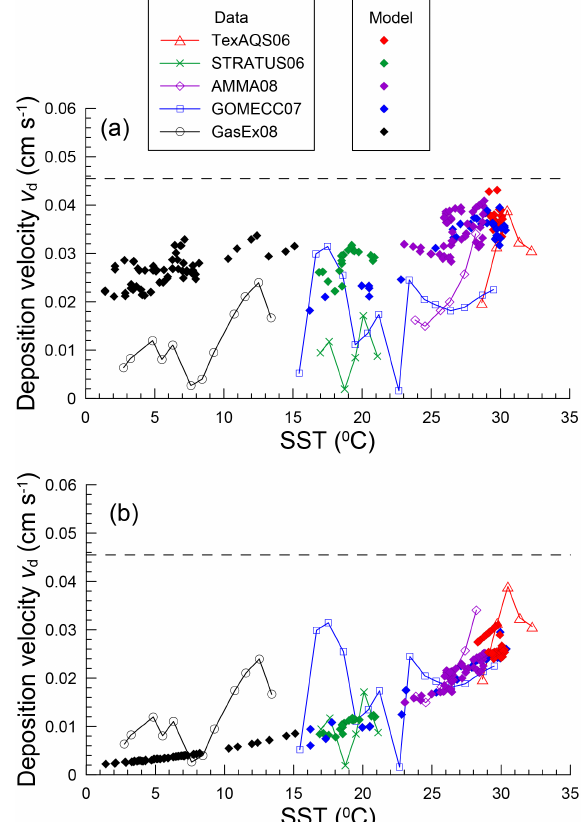
Figure 2. Ozone dry deposition velocity ( v d ) as a function of sea surface temperature (SST) from five field experiments (Helmig et al., 2012; L. Bariteau, personal communication, 2016) and the cor- responding values obtained from the ACCESS-UKCA model us- ing (a) the one-layer reactivity scheme for ozone deposition to the ocean and (b) the one-layer reactivity scheme without waterside tur-